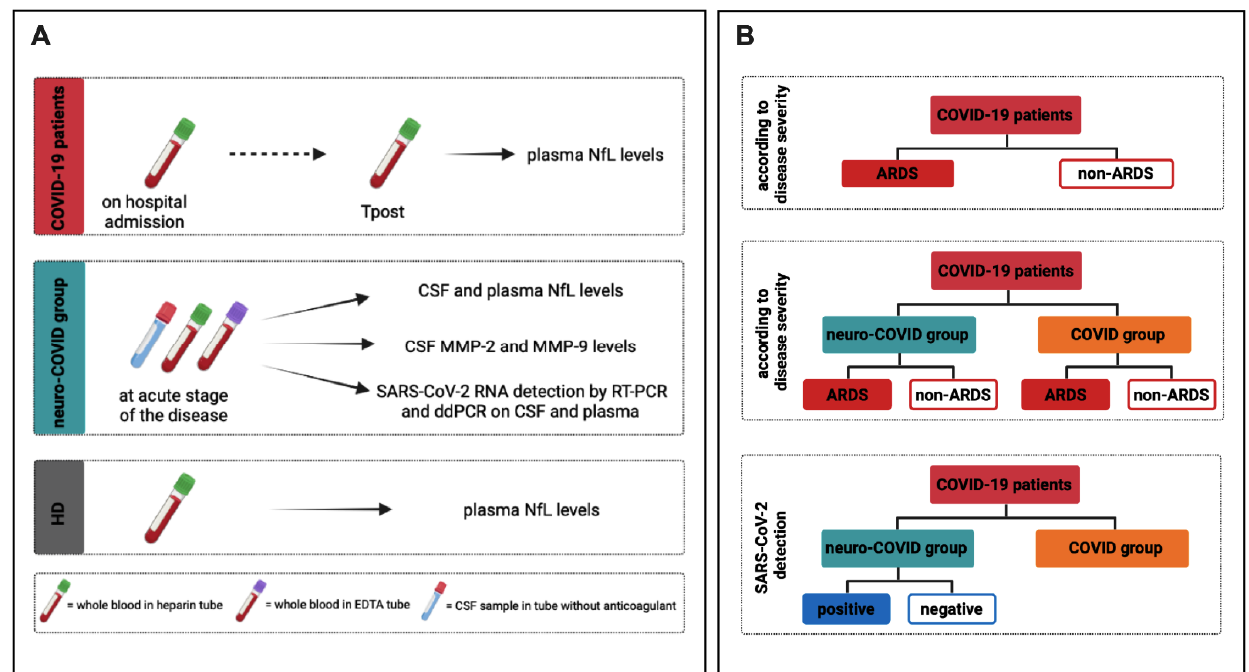
Figure 1. Study design. ( A ) For COVID-19 patients, whole blood samples were collected in heparin tubes during routine clinical testing at two timepoints: on hospital admission (baseline) and after three months from discharge (Tpost). For the neuro-COVID group, CSF samples and heparin and EDTA whole blood samples were collected. RT-PCR and ddPCR were used for the detection and quantification of SARS-CoV-2 RNA in collected CSF and whole blood samples. For healthy donors (HD) heparin whole blood samples were collected. ( B ) According to clinical outcome, COVID-19 patients were stratified into ARDS and non-ARDS groups and the differences in plasma NfL levels were evaluated. According to disease severity, both neuro-COVID group and COVID groups were stratified into ARDS and non-ARDS groups and the differences in CSF NfL levels, plasma NfL levels, and CSF MMP-2 and MMP-9 levels were assessed. According to the detection of SARS-CoV-2 RNA in CSF and plasma samples, neuro-COVID group was stratified into positive and negative groups and the differences in CSF NfL levels as well as MMP-2 and MMP-9 levels were evaluated. Neuro-COVID group: COVID-19 patients with severe neurological symptoms; COVID group: COVID-19 patients without severe neurological symptoms; NfL: neurofilament light chain; MMP-2: matrix metalloprotease-2; MMP-9: matrix metalloprotease-9; SARS-CoV-2: severe acute syndrome coronavirus 2; RT-PCR: reverse transcription-polymerase chain reaction; ddPCR: droplet digital polymerase chain reaction; CSF: cerebrospinal fluid; HD: healthy donors; EDTA: ethylenediaminetetraacetic acid; ARDS: acute respiratory distress